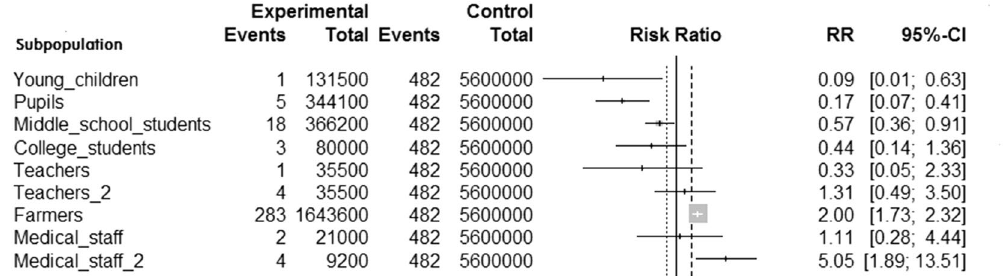
Figure 2. Risk of different populations compared with that of the whole population. Teachers: teachers outside rural areas. Teachers_2: teachers in rural areas. Medical staff: medical staff outside rural areas. Medicalstaff_2: medical staff in rural areas.